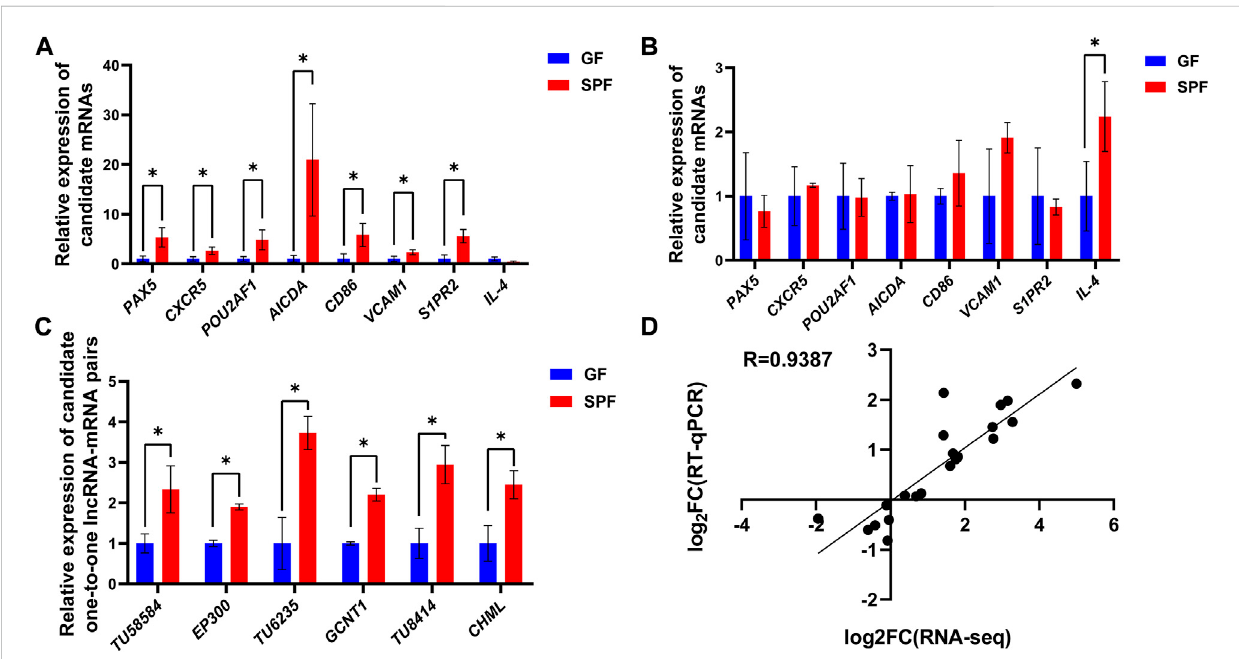
FIGURE 8 Gene expression validation by RT-qPCR. The relative expression levels of candidate genes in JPPs (A) and IPPs (B) were detected by RT-qPCR. (C) TherelativeexpressionlevelsoflncRNA – mRNApairsinJPPs. (D) CorrelationanalysisbetweenRNA-seqandRT-qPCRresults.Means±SDsarepresented for each group. n = 3. * p <